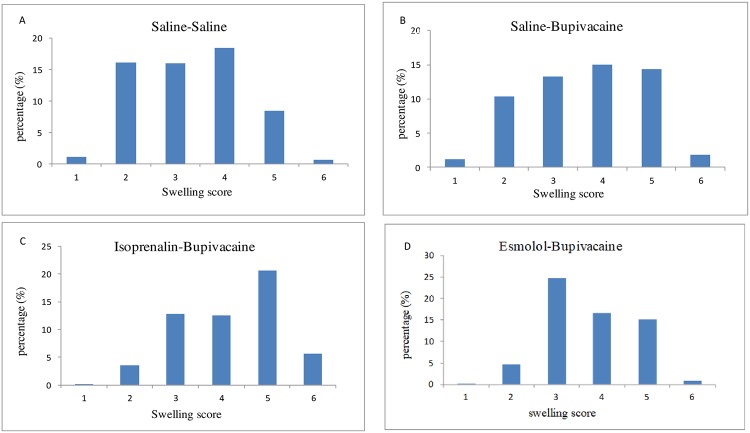
Mitochondrial damage score.Each graph depicts the mitochondrial damage score (0 = no swelling to 5 = maximum swelling) distribution in percent of n evaluated mitochondria in each group. (A) Control mice were pretreated with saline and then received saline i.p. (B), (C) and (D) Mice were pretreated with saline, isoprenalin or esmolol, and then received bupivacaine i.p. The intergroup differences of mitochondrial swelling scores were tested by the Kruskal-Wallis method followed by Nemenyi test for multiple comparisons. The order of the groups according to damage score is as follows: isoprenalin + bupivacaine group (C) > saline + bupivacaine group (B) > esmolol + bupivacaine group (D) > saline + saline group (A) (P < 0.01, between each two groups).